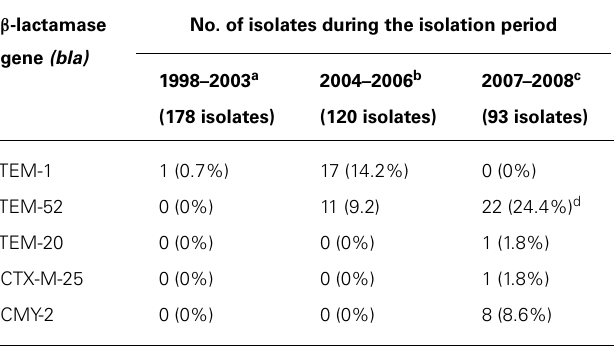
Table 3 | Chronological change of β -lactamase genes in serovar Infantis β